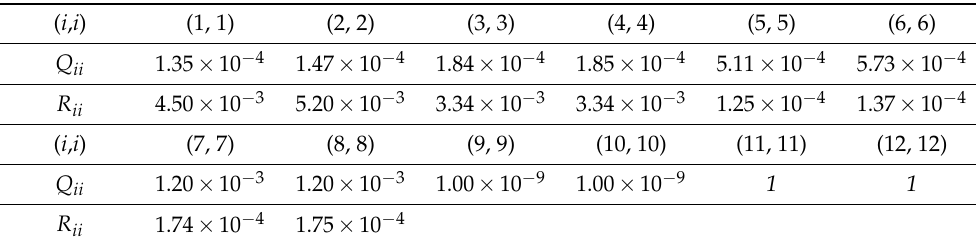
Table 3. Variance–Covariance Matrix